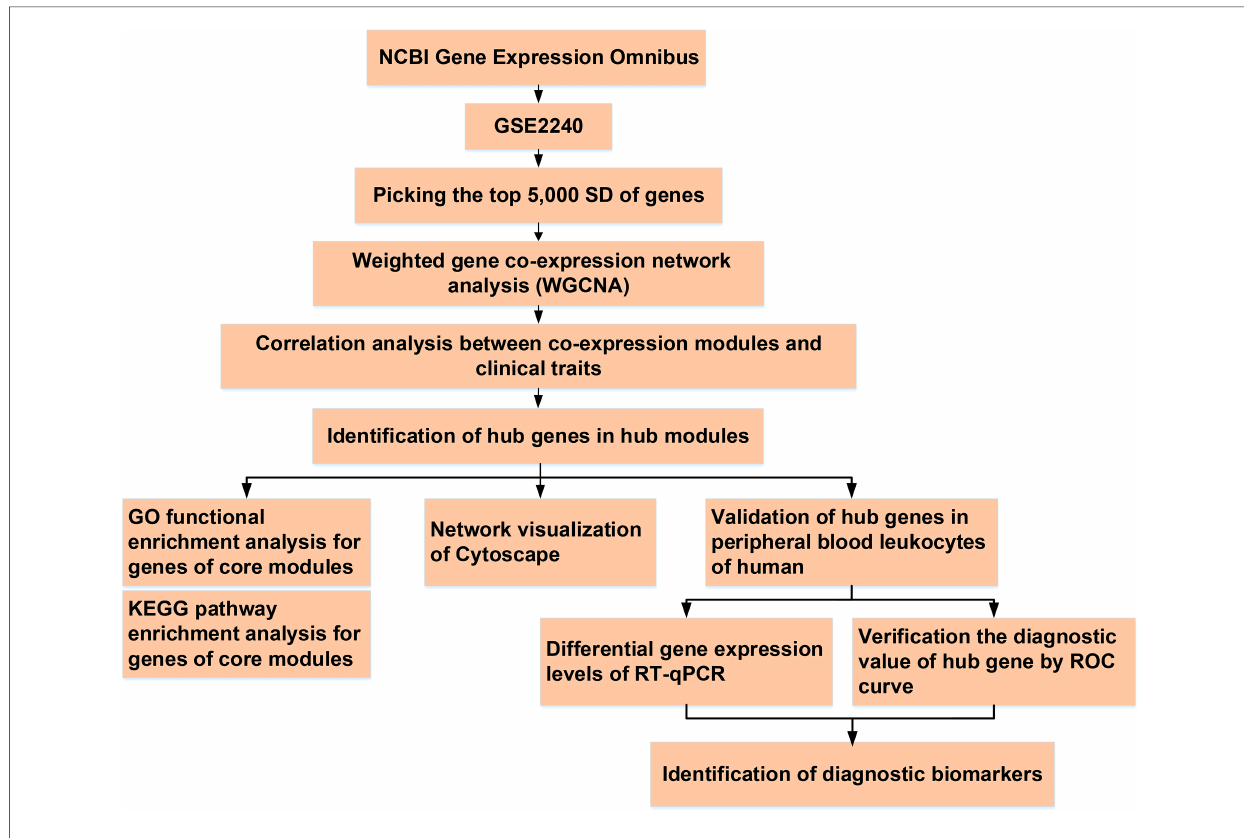
FIGURE 1 The fl owchart of analysis